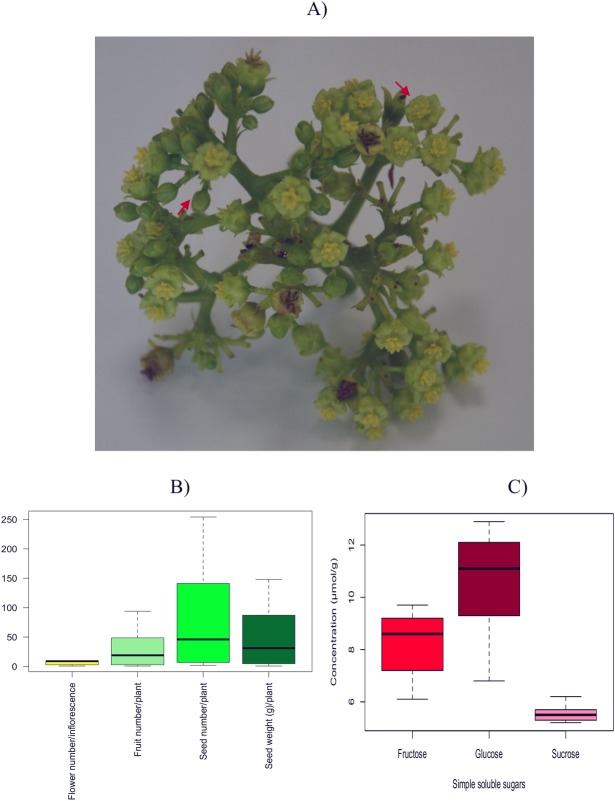
The Jatropha curcas inflorescence: Physical data and simple soluble sugars.A) A two-year-old mature inflorescence obtained from the UKM JC-17 accession. Red arrows indicate buds and bloomed flowers. B) Box plots indicate metric quantifications of flower number per inflorescence, fruit number per plant, seed number per plant and seed weight expressed in grams per plant. C) Box plots indicate concentrations of fructose, glucose and sucrose in J. curcas inflorescence expressed in μmol/g. All measurements (B and C) for each treatment were taken from 5 biological replicates.